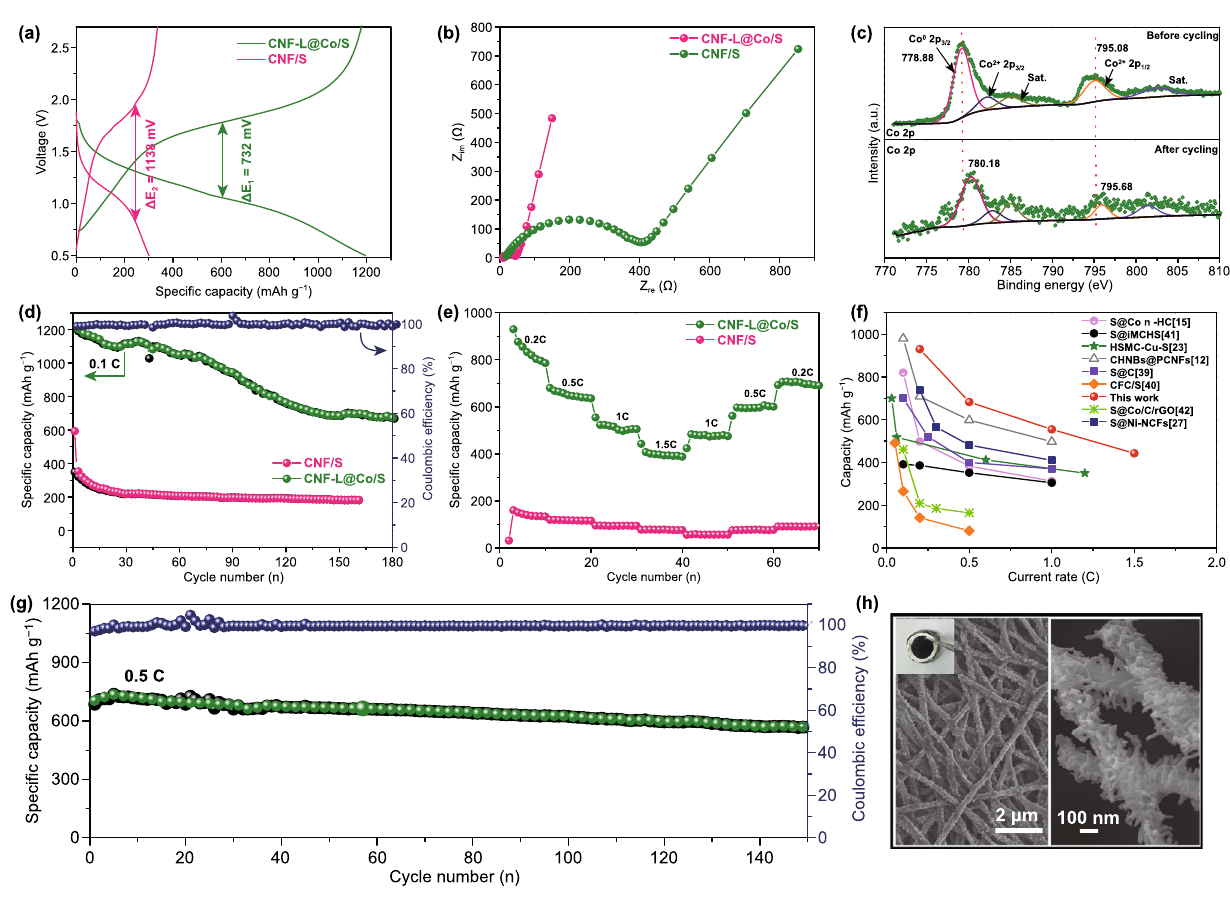
Fig. 3 a Comparison of discharge/charge curves. b Comparison of electrochemical impedance spectra. c High‑resolution XPS spectra of Co 2p before and after cycling. d Cycling performance and Coulombic efficiency of CNF‑L@Co/S and CNF/S at 0.1 C. e Rate performance of CNF‑L@Co/S and CNF/S. f Comparison of the rate capabilities with previously reported RT Na‑S batteries. g Long‑term cycling stability of CNF‑L@Co/S at 0.5 C, and h FESEM images of the CNF‑L@Co/S composite after